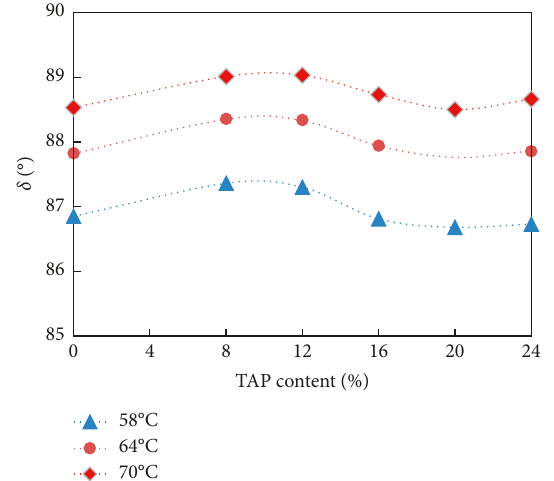
Figure 11: Variation in the d values of TAP-modified asphalt with TAP